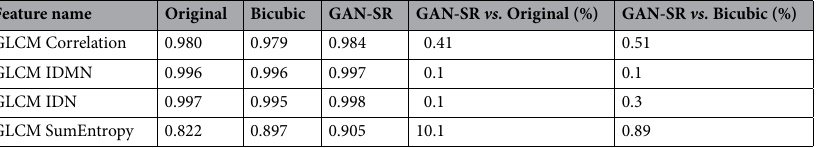
Table 2. Relative difference (in terms of ICC) of the GAN-SR against the Original and Bicubic versions on the most important radiomic features according to PCA